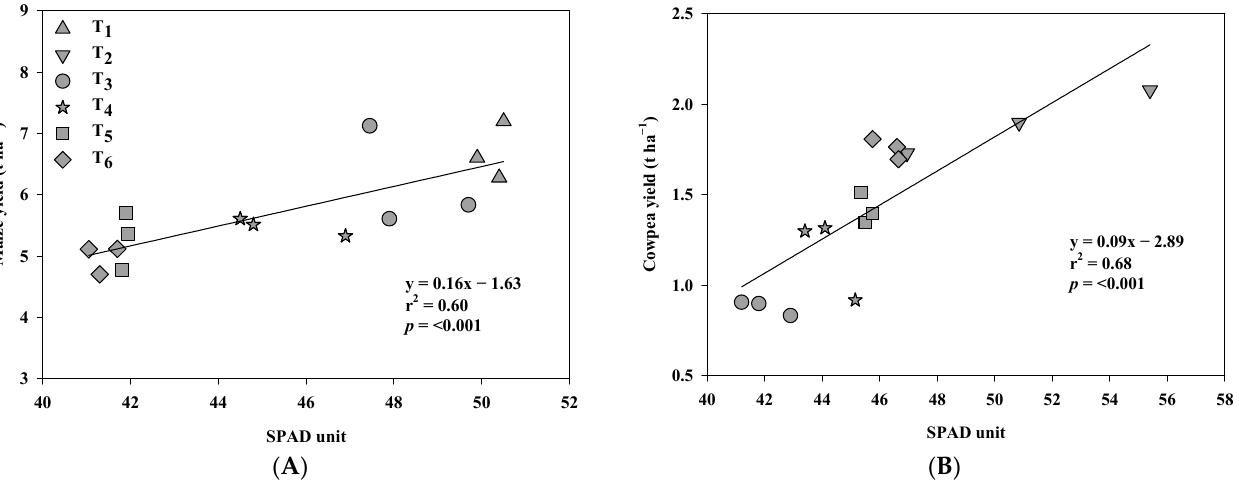
Figure 3. Relationship between soil and plant analysis development (SPAD) value and seed yield of maize (panel ( A )) and cowpea (panel ( B )).